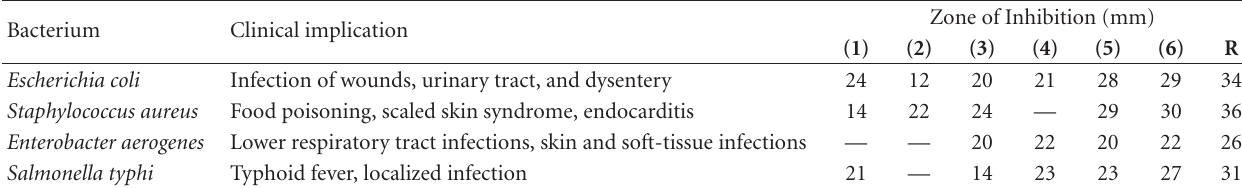
Table 4: Antibacterial activity a,b of the free ligand ( 1 ) and its organotin(IV) complexes 2–6 (inhibition zone in mm). Bacterium